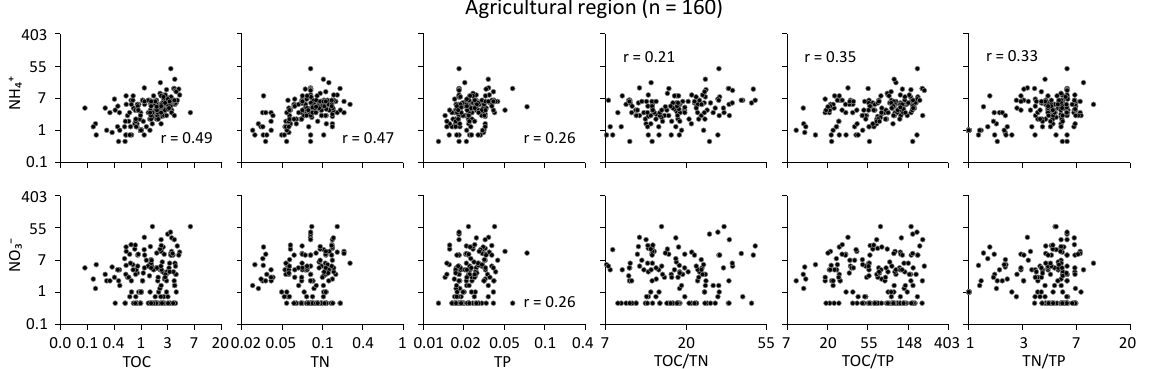
+ and NO − (mgNkg − 1 ), scatter plots of total organic C (TOC), total N (TN), total P (TP), and element ratios on the Figure 5. For NH 4 3 log-transformed scale in the agricultural region. The unit is expressed as percent C, N, or P by weight of soil. Pearson’s correlation coefficient is reported only when the trend is significant ( p < 0 . 05).